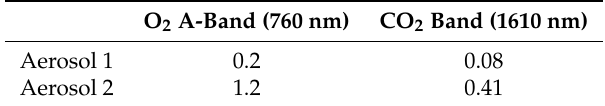
Table 1. Aerosol optical thickness used in the simulations for O 2 A- and CO 2 bands at the middle of the corresponding absorption